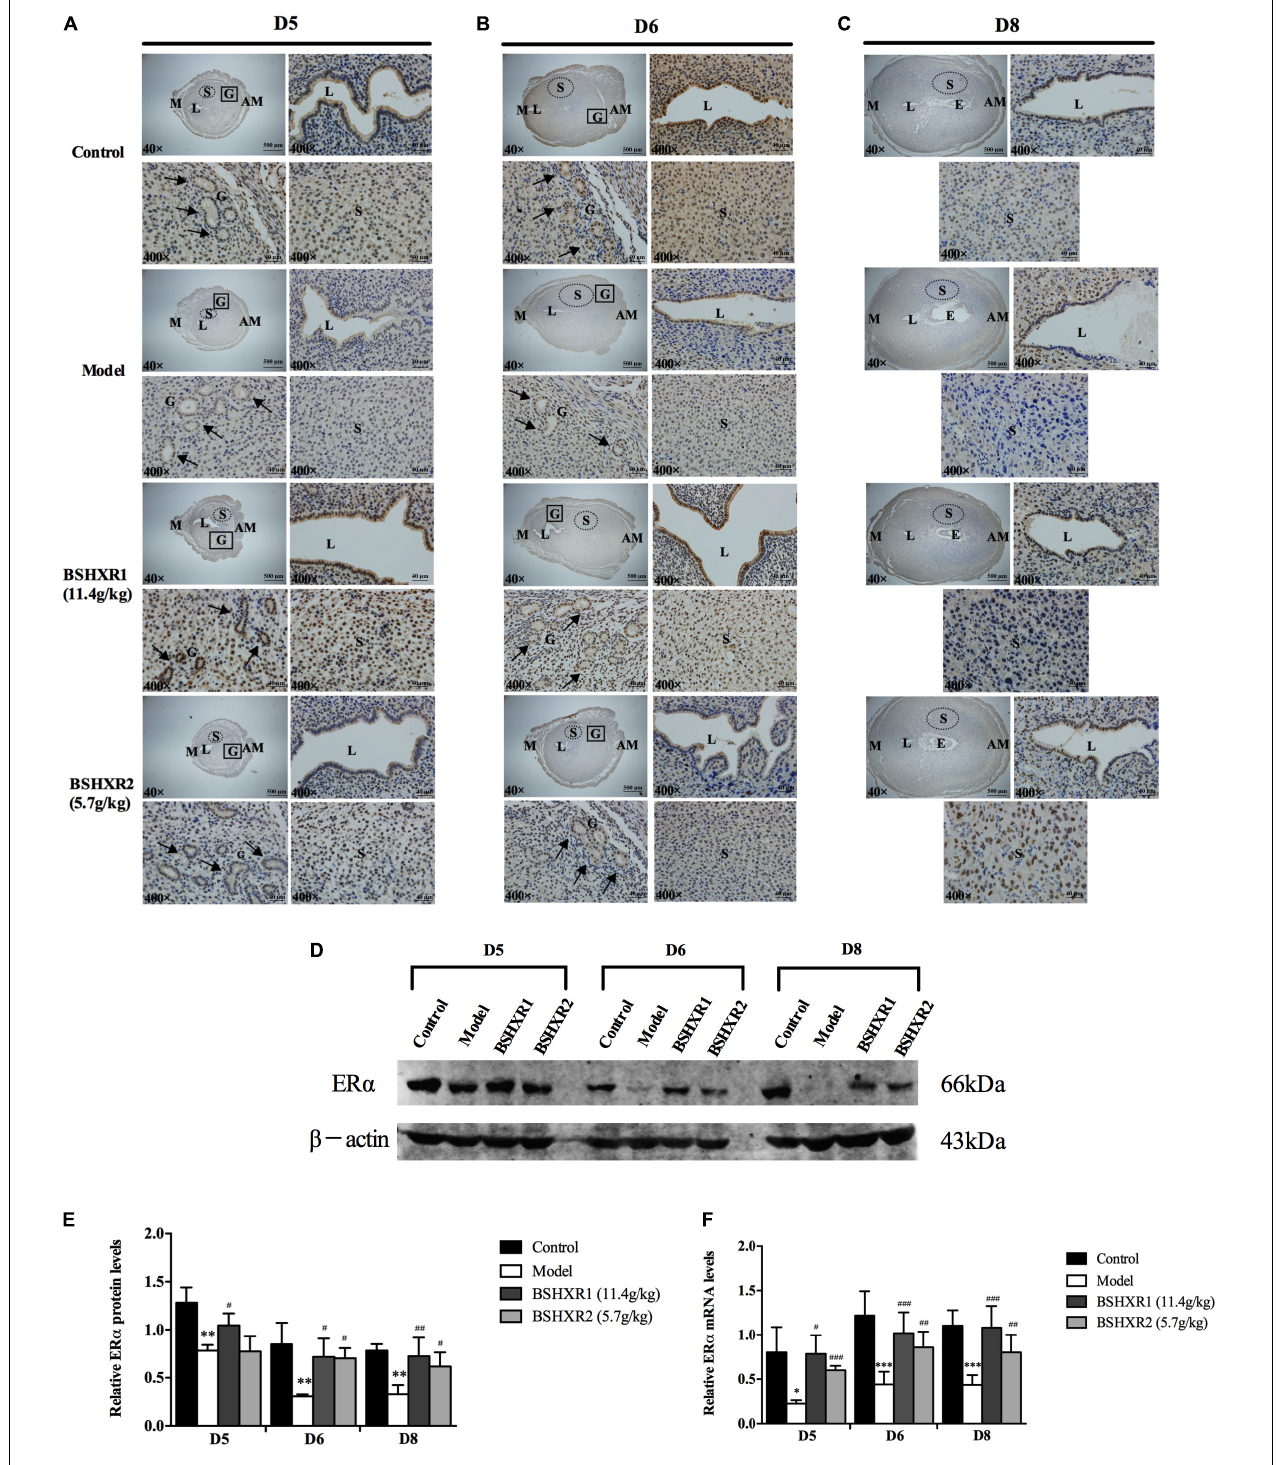
FIGURE 6 | ER α expression in the uterus on D5, D6 and D8. (A) Immunohistochemistry of ER α in paraffin sections of the uterus on D5 (A) , D6 (B) , and D8 (C) . For each group (control, model, BSHXR1, and BSHXR2), a low magnification image of the uterus is depicted, as well as higher magnification images of the lumen (L), gland (G), and stroma (S). E, embryo; M, mesometrial; AM, anti-mesometrial; L, lumen; G, gland; S, stroma. Arrows indicate glands. Original magnification and scale bar were shown in images. (D) Protein levels of ER α in pregnant uterus (remove embryo) by western blot analysis ( n = 3). (E) Quantification of ER α protein expression. (F) mRNA levels of ER α in pregnant uterus (remove embryo) by qRT-PCR ( n = 5). Data represent mean ± SD. β -actin was used as the reference. ∗ P < 0.05, ∗∗ P < 0.01, and ∗∗∗ P < 0.001 when compared to control group. # P < 0.05, ## P < 0.01, and ### P < 0.001 when compared to model group.